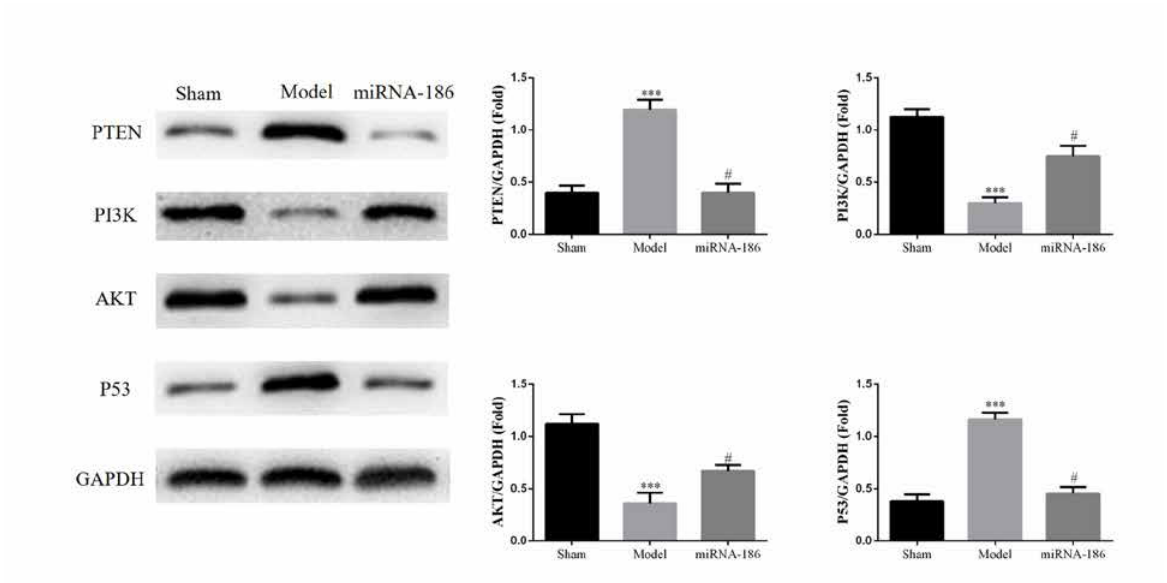
Figure 3: The relative proteins expressions of difference groups, ***: P < 0.05, compared with Sham group, #: P < 0.05, compared with Model group